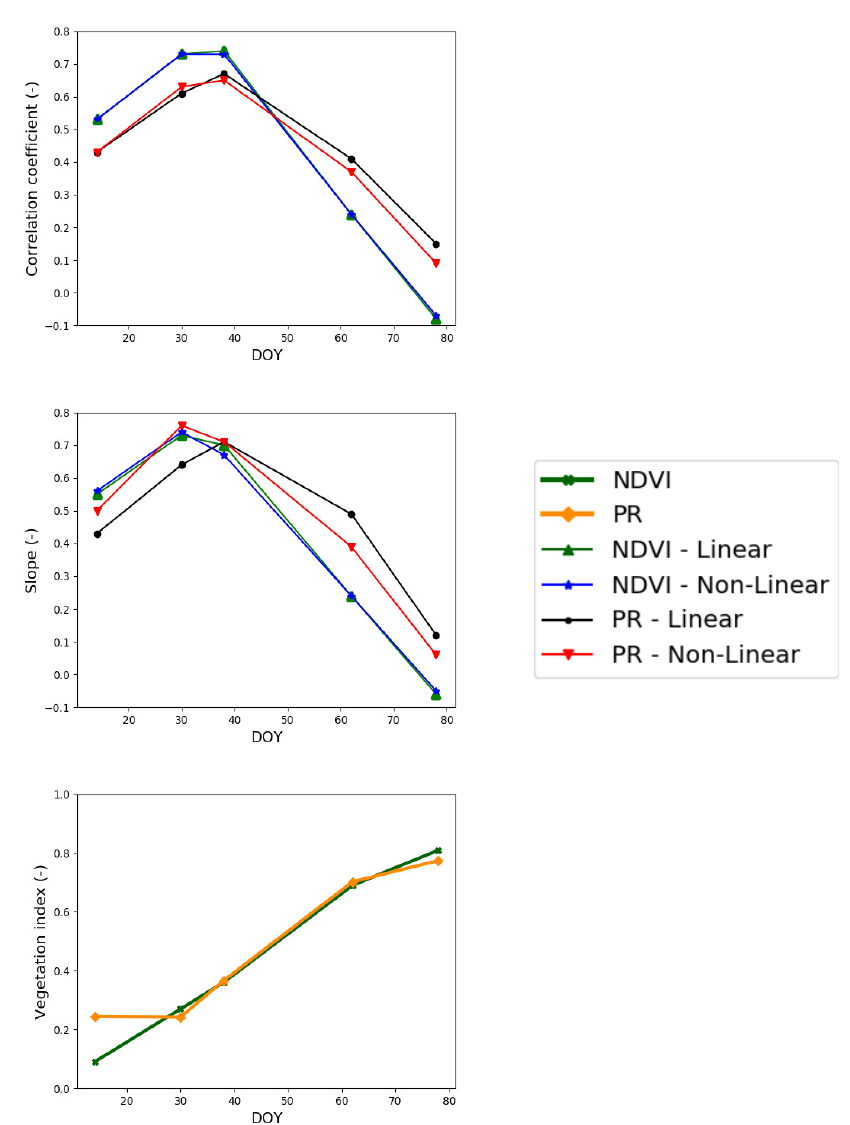
Figure 7. Time series of the correlation coefficient and slope of the linear regression between predicted and in situ SM for both (linear and non-linear) RTM, two vegetation descriptors (NDVI and PR) separately, and where in situ SM datasets are used for the